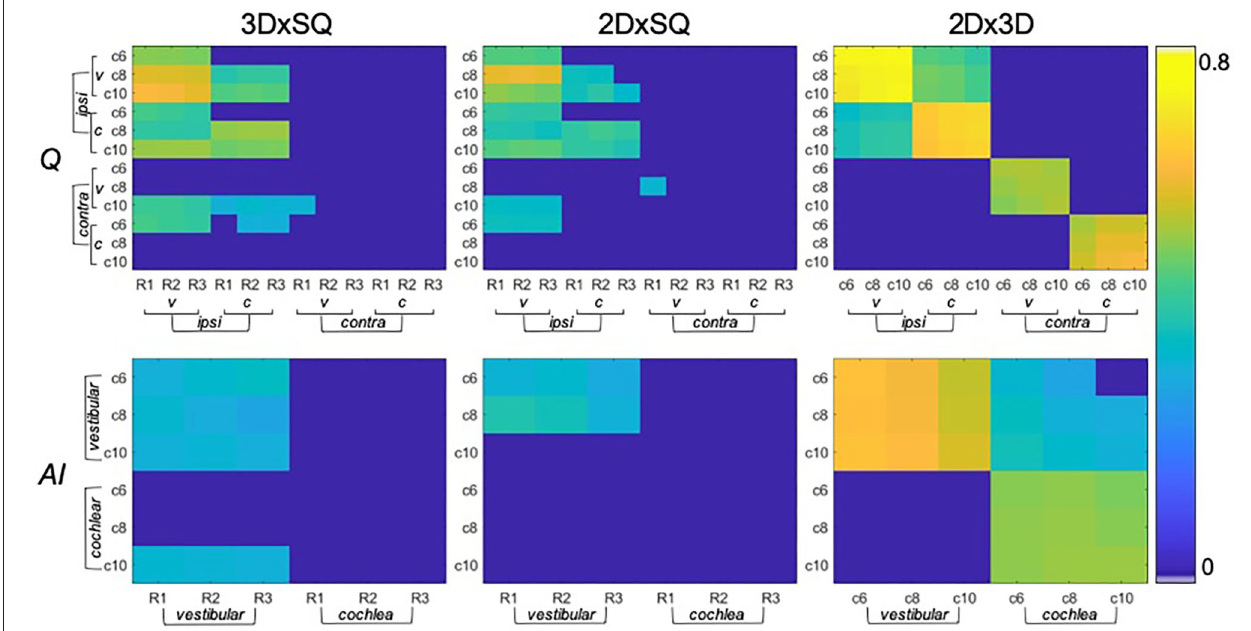
FIGURE 3 | Significant correlations between endolymphatic hydrops (ELH) quantification methods (belonging to question ii). The top row shows the correlations between semi-quantitative (SQ) gradings (x-axis) and 2D- or 3D- quantification values (y-axis) for vestibulum (v) or cochlea (c), and for the ipsilateral (ipsi) or contralateral side (contra). In addition, SQ gradings are rater-specific (R1-R3), and 2D- or 3D- quantification values are cutoff-specific (c6, c8, and c10). The higher the significant results ( p < 0.05 FWE-corrected) correlated, the more they are colored in yellow (thresholded to 0–0.8). Overall, SQ gradings and 2D- or 3D-quantification values correlated with the respective other method, although to a higher extent on the ipsilateral side (on the contralateral side in c10) and vestibular part of the inner ear. The bottom row shows the corresponding correlations between methods (SQ gradings and 2D- or 3D- quantification values) for the respective asymmetry-index ( AI ).